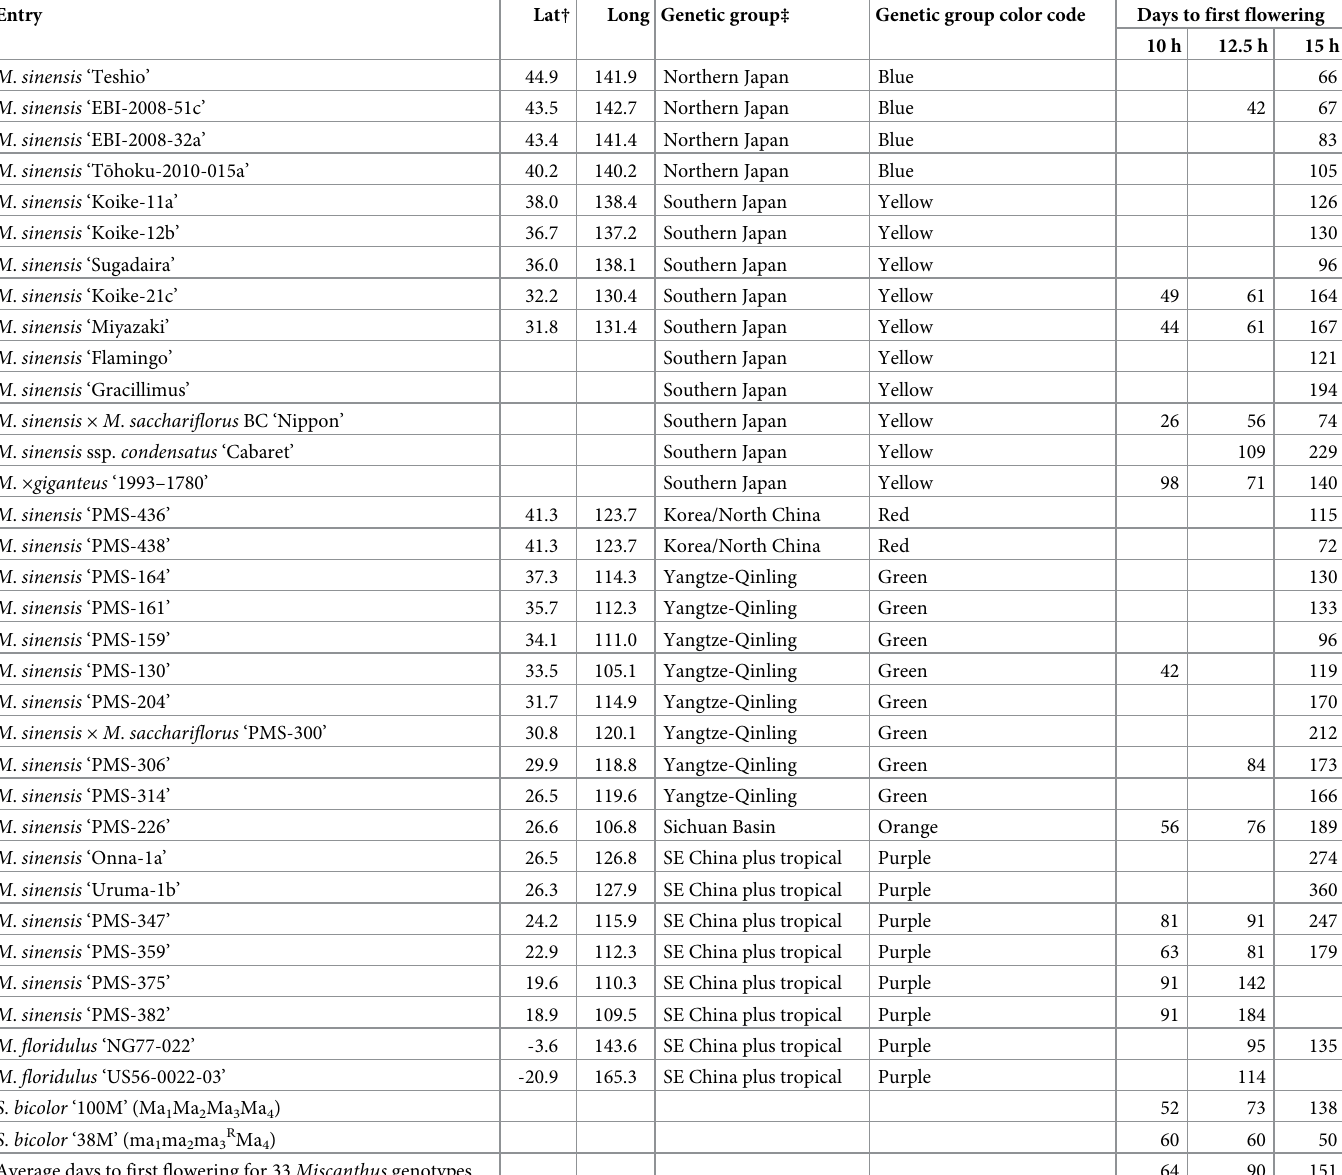
Table 3. The 33 Miscanthus genotypes and two Sorghum controls included in a study on the effect of day length on flowering time, conducted in controlled environ- ment